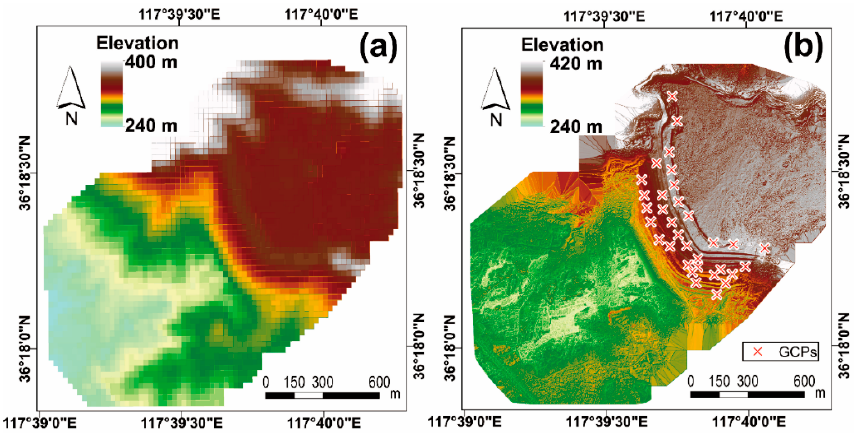
Figure 6. AW3D30 DSM ( a ) and UAV SfM DSM ( b ) of the research area.